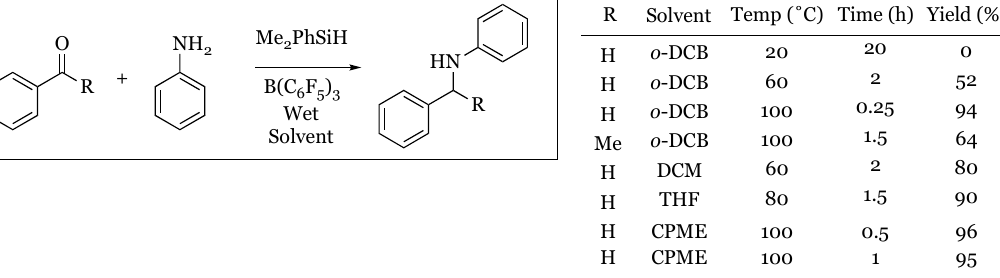
Figure 19. Reductive amination of aniline and benzaldehyde (acetophenone) with various solvents, temperatures, and reaction times to produce N -benzyl aniline products.